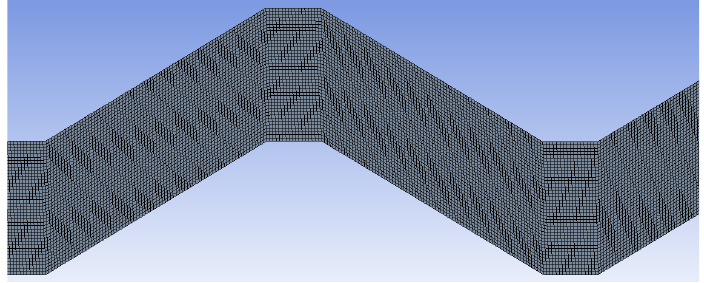
Figure 6. A view of a section of the mesh of the numerical domain.